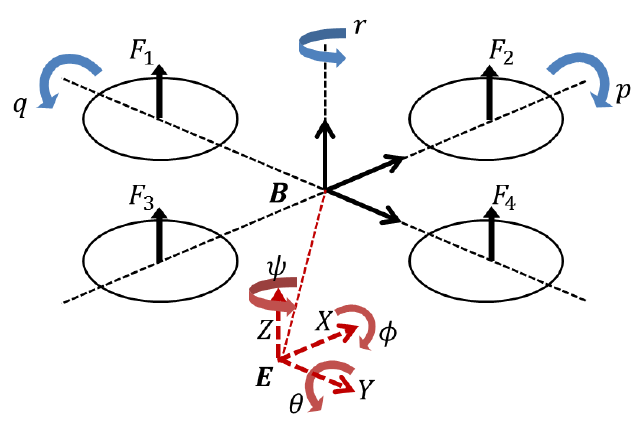
Figure 1. The coordinates and thrusts of a